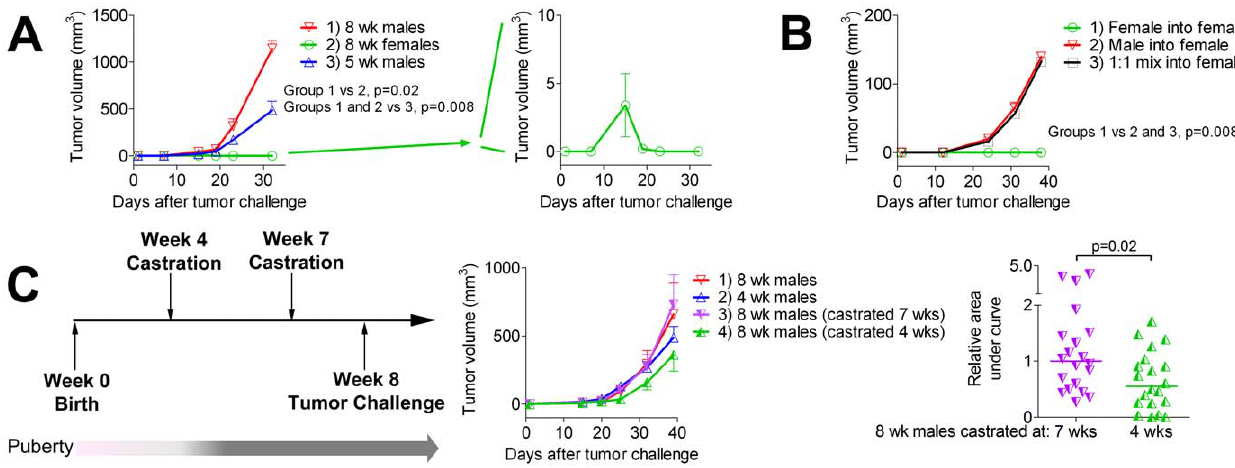
Figure 1. Female mice reject TRAMP-C2 prostate cancers while male mice develop tolerance following puberty. A) TRAMP-C2 tumor cells grow progressively in adult male mice, with a slower kinetic but complete penetrance in pre-pubescent male mice, and grow briefly but then are rejected in adult female mice. n=5 mice/group, one of 2 experiments with similar results. B) Adult female mice were transplanted with female, male, or a 1:1 mixture of female and male T-cell depleted bone marrow and 10 weeks after transplantation challenged with TRAMP-C2 tumors. n=5 mice/ group, results of a single experiment. C) Preventing onset of puberty in male mice can mediate delayed growth of TRAMP-C2 tumors. Adult male mice surgically castrated before onset of puberty (4 weeks) show delayed growth of TRAMP-C2, while castration 1 week prior to tumor challenge (7 weeks) had no effect on tumor growth. n=10 mice/group, tumor growth curve and area under curve normalized to median value for group 3 from each experiment. Combined results of 2 experiments.